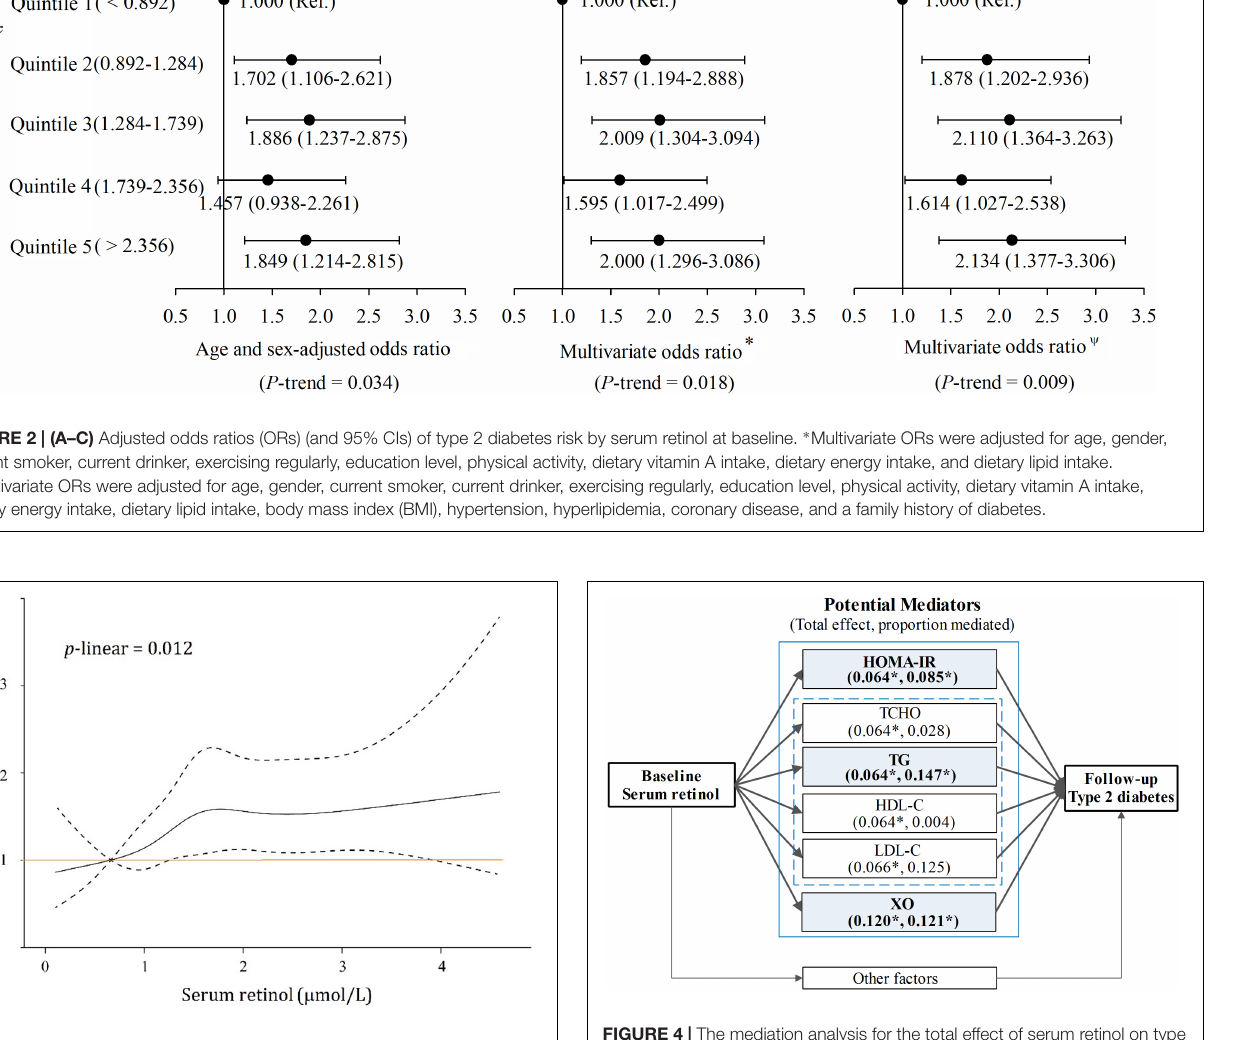
FIGURE 3 | Association between serum retinol and type 2 diabetes risks. Black solid line, multivariate odds ratios; dotted lines, 95% confidence intervals.